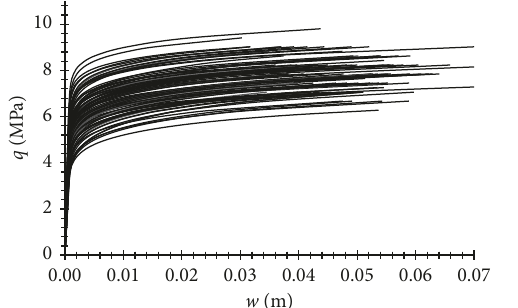
Figure 4: Deflection in the center of the plate with uniform load.